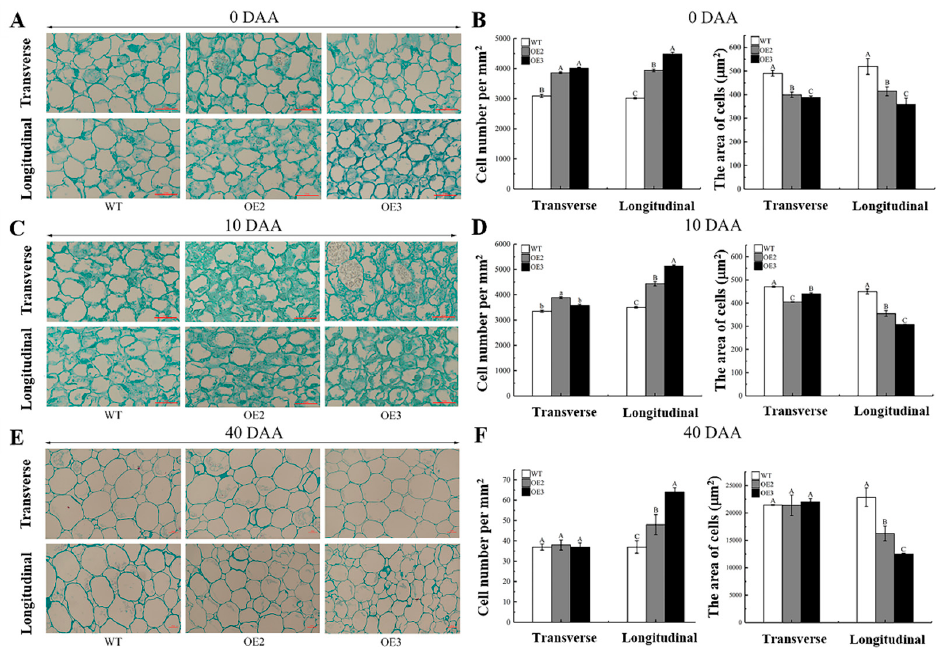
Figure 6. Cell morphology in the central columellae of tomato fruits from wild type plants and transgenic lines. ( A , C , E ) Microscopic view of fruit central columella cells in transverse (top panel) and longitudinal directions (lower panel) from wild type (WT) plants and two transgenic lines OE2 and OE3 at 0 days after anthesis (0 DAA, ( A )), 10 DAA ( C ) and 40 DAA ( E ). Scale bars represent 25 μ m in ( A , C ) and 100 μ m in ( E ), respectively. Three biological repeats were performed. ( B , D , F ) Cell number (left panel) and area (right panel) in transverse and longitudinal directions in the central columellae of tomato fruits from WT, OE2, and OE3 at 0 DAA ( B ), 10 DAA ( D ), and 40 DAA ( F ), respectively. In ( B , D , F ), data are displayed as mean ± standard deviation of three biological repeats in the left panels and of at least 120 cells in the right panels. Different capital and lower letters indicate significant differences at the statistical levels of 0.01 and 0.05, respectively (unpaired two- tailed t -test).